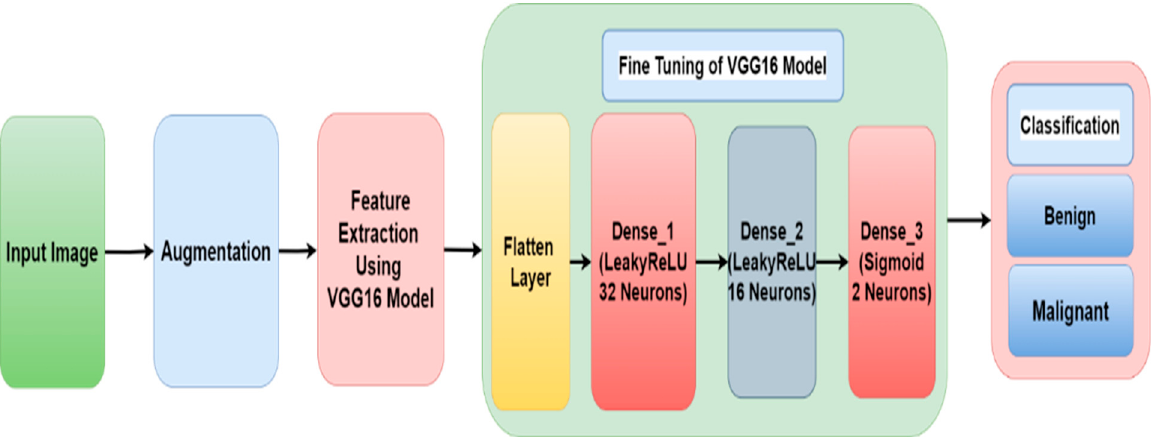
Figure 1. Proposed Framework Model.